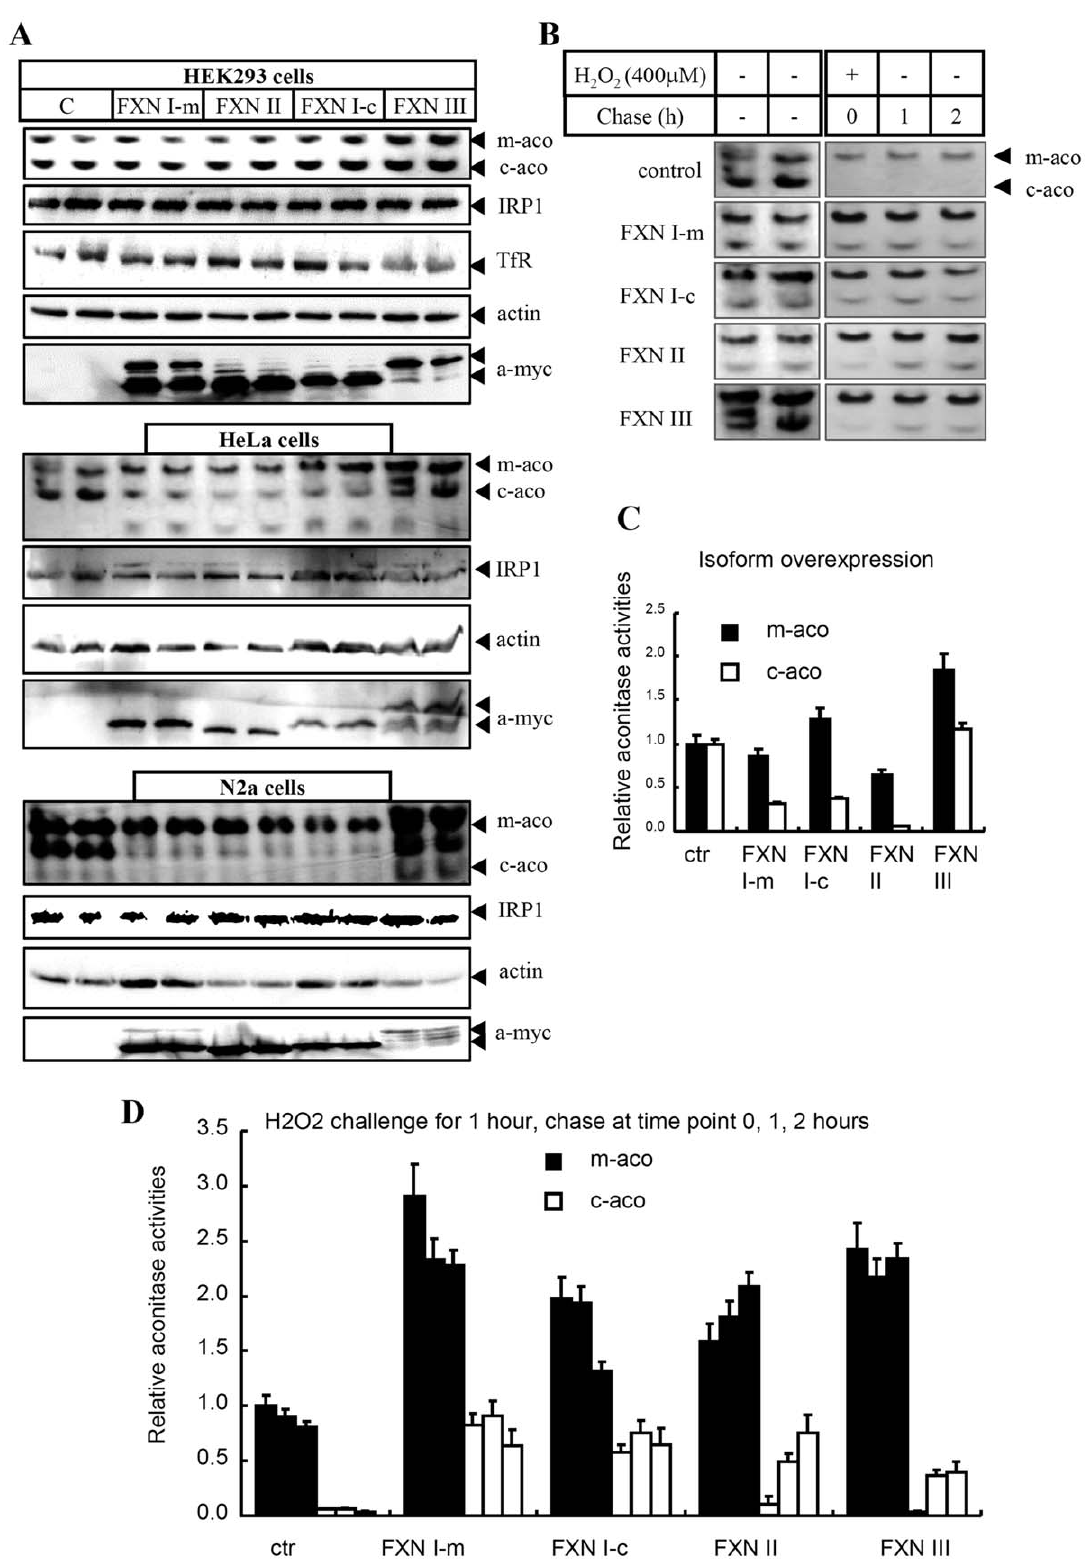
Figure 5. Functional assays of human FXN isoforms in cell lines. ( A ) Each of FXN isoforms was over-expressed in cell lines HEK293, HeLa, and N2a, respectively. Harvested cells were lysed 48 hours post-transfection for aconitase assay and western blot (see Methods and Materials). For each cell line, the top two panels are aconitase assays; the rest are Western blot results. FXN I-m, full-length mitochondria-localized FXN isoform I; FXN I-c, mature form of FXN isoform I, cytosol-localized. m-aco: activities of mitochondrial aconitase; c-aco: activities of cytosolic aconitase, which is Fe-S